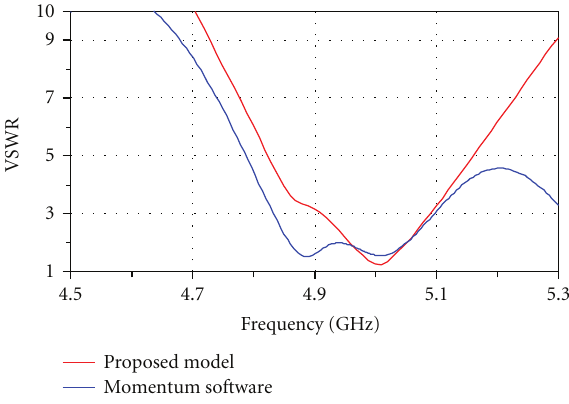
thickness h of 1.6 mm, and a loss tangent of about 0.019 and 0.05 mm conductor thickness.